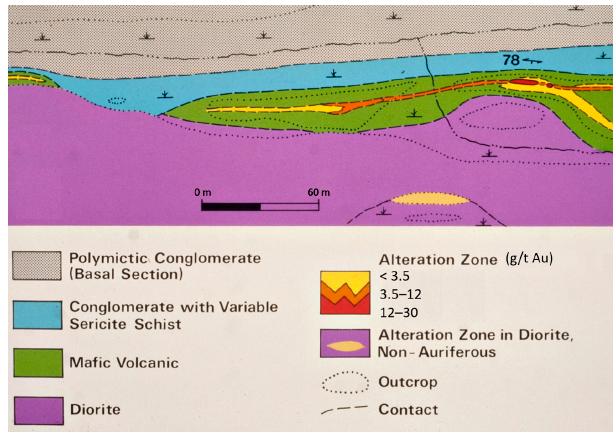
Figure 2. Surface geology of the Brookbank deposit.